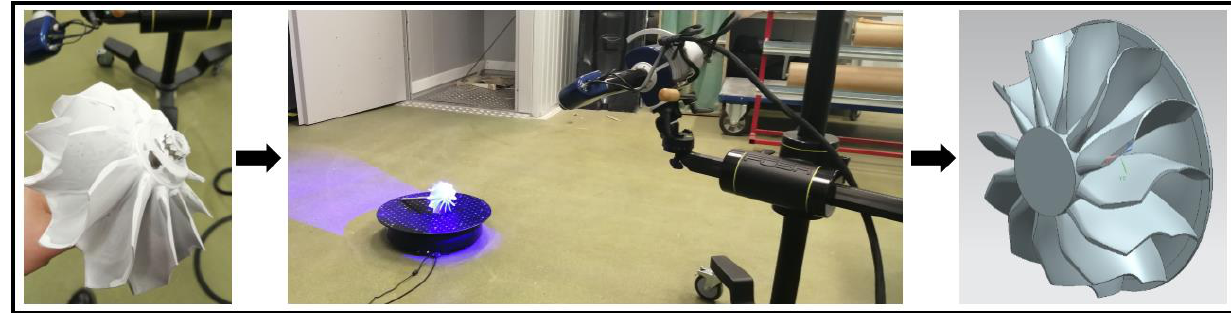
Figure 7. The scanning process of rotor A [27].